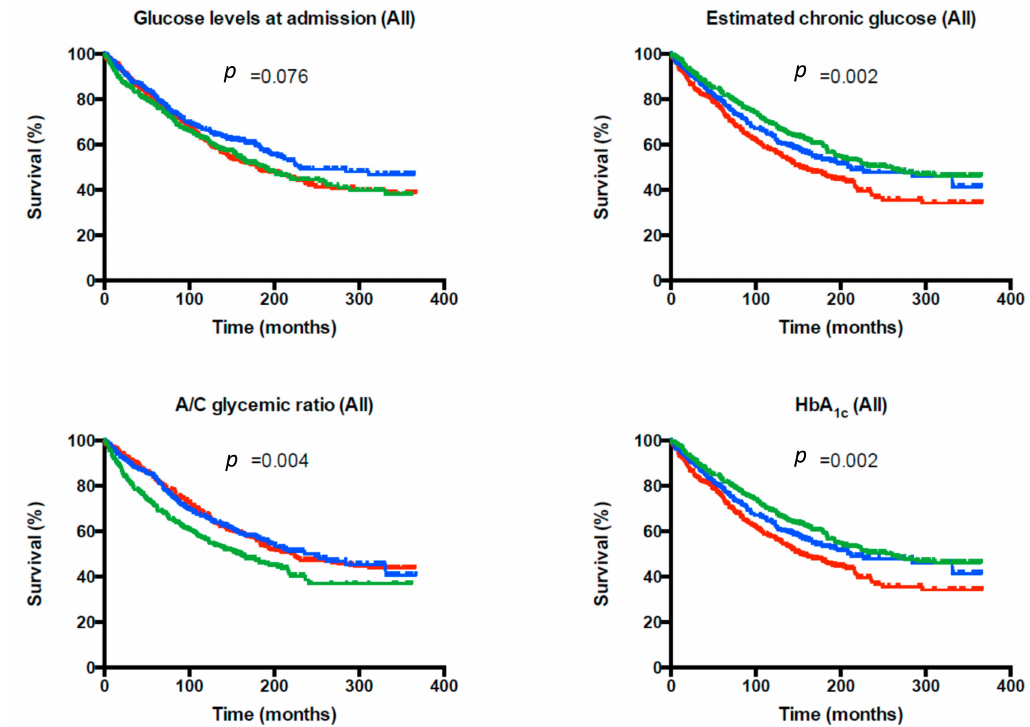
Figure 3. Kaplan–Meier survival curves for all-cause mortality according to the tertiles (first tertile: green, second tertile: blue, third tertile: red) of glucose levels at admission, estimated chronic glucose levels, acute to chronic glycemic ratio, and HbA1c for the whole